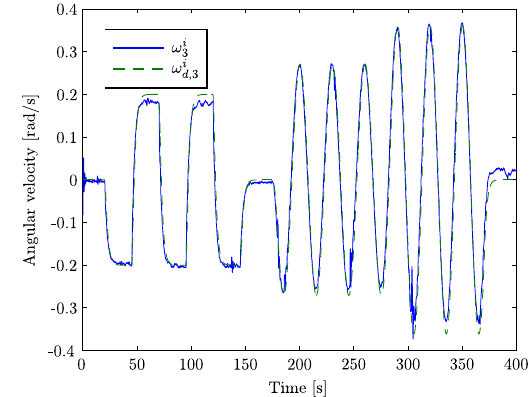
Figure 4: Experiments without observer. Comparing the angular velocity against the desired gen- eralized velocity.